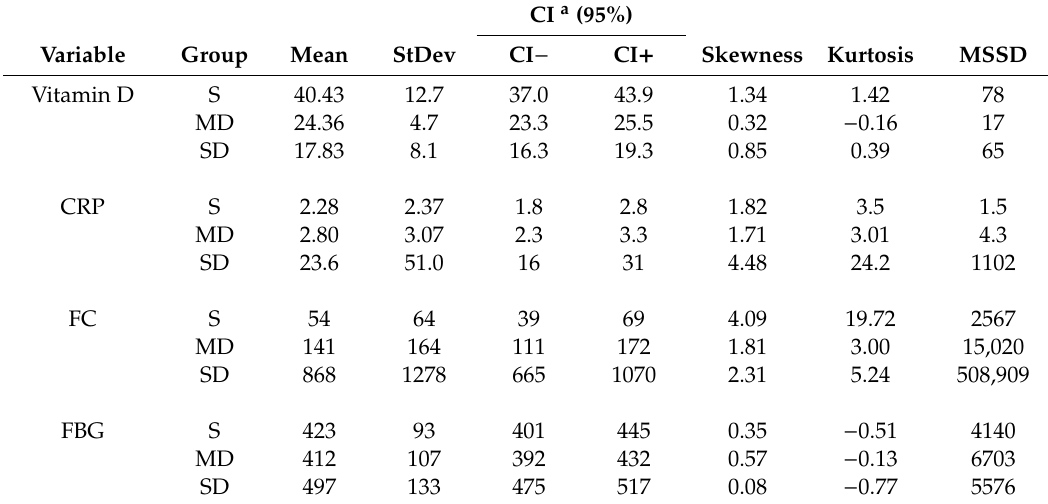
Table 1. Statistical parameters obtained from vitamin D and inflammatory markers grouped according to vitamin D content.